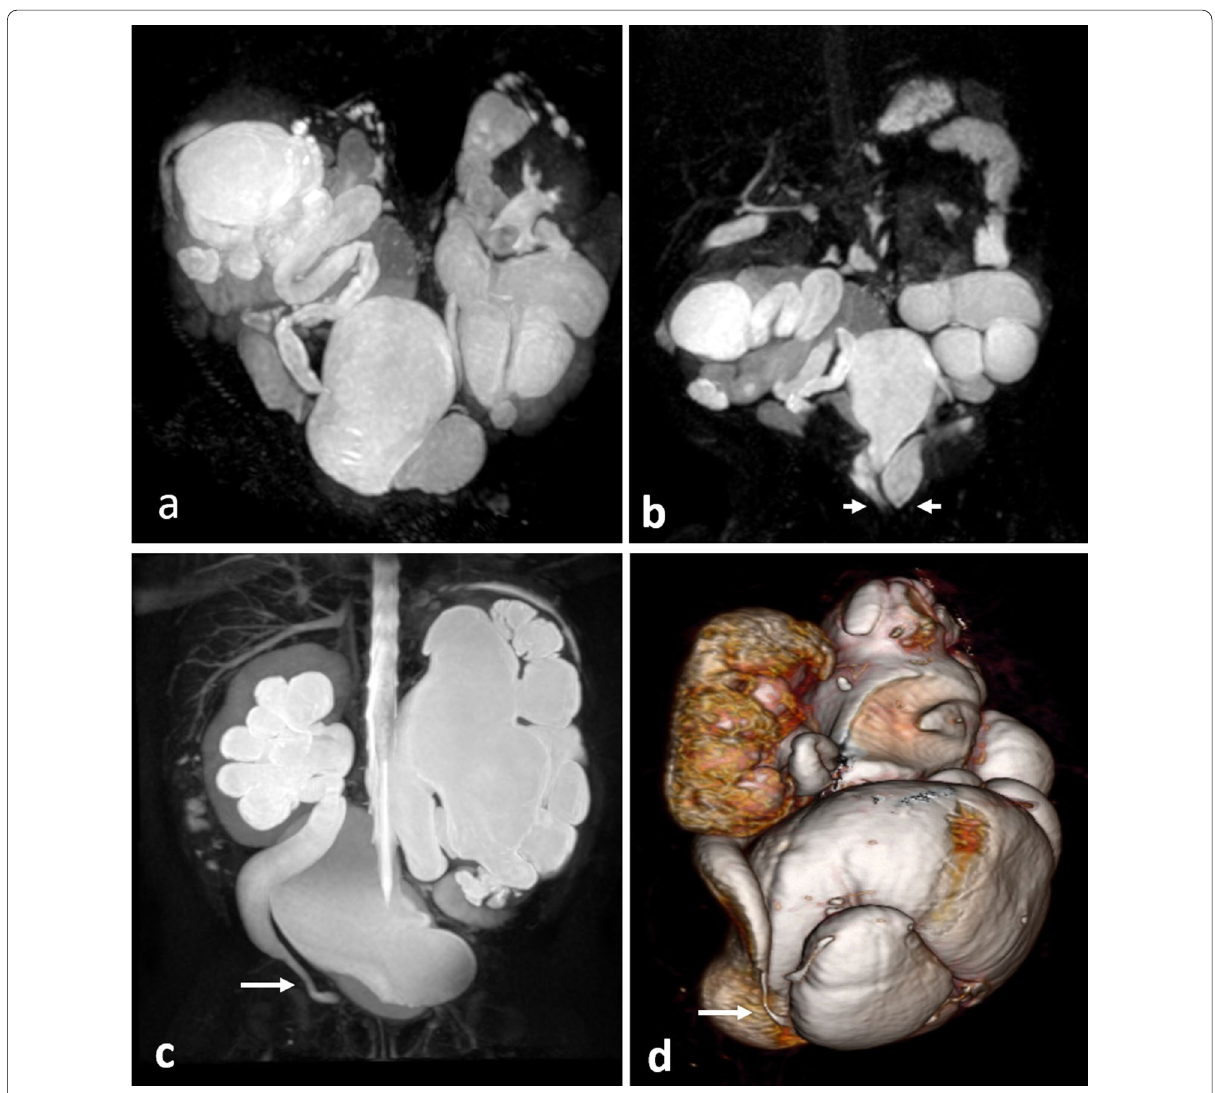
Fig. 4 MRU in two cases with complex renal anomalies. a , b 1-month-old neonate with complex renal anomalies. Bilateral duplex system with ectopic ureteric insertions (arrow heads). The renal parenchyma of the upper moieties on both sides is thinned with multiple renal cysts. c , d MIP and 3D reformat show bilateral obstructive megaureter (note the distal ureteric narrowing characteristic of primary megaureter